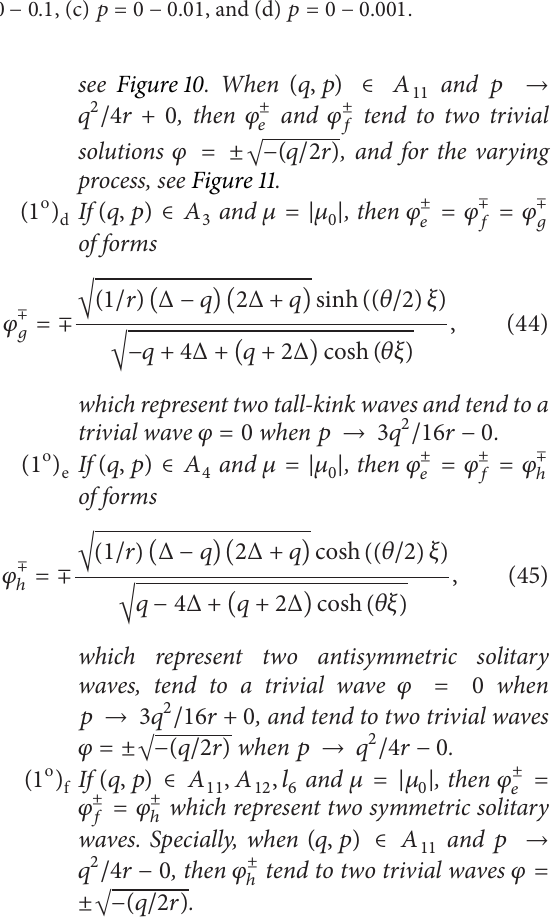
Figure 4: (The symmetric solitary waves are bifurcated from the symmetric periodic waves.) The varying process for the figures of 𝜑 ± 𝑎0 when 𝑝 → 0 − 0 , where 𝑟 = −1 , 𝑞 = 4 and (a) 𝑝 = 0 − 0.5 , (b) 𝑝 = 0 − 0.1 , (c) 𝑝 = 0 − 0.01 , and (d) 𝑝 = 0 − 0.001 (𝑞,𝑝) ∈ 𝐴 12 and